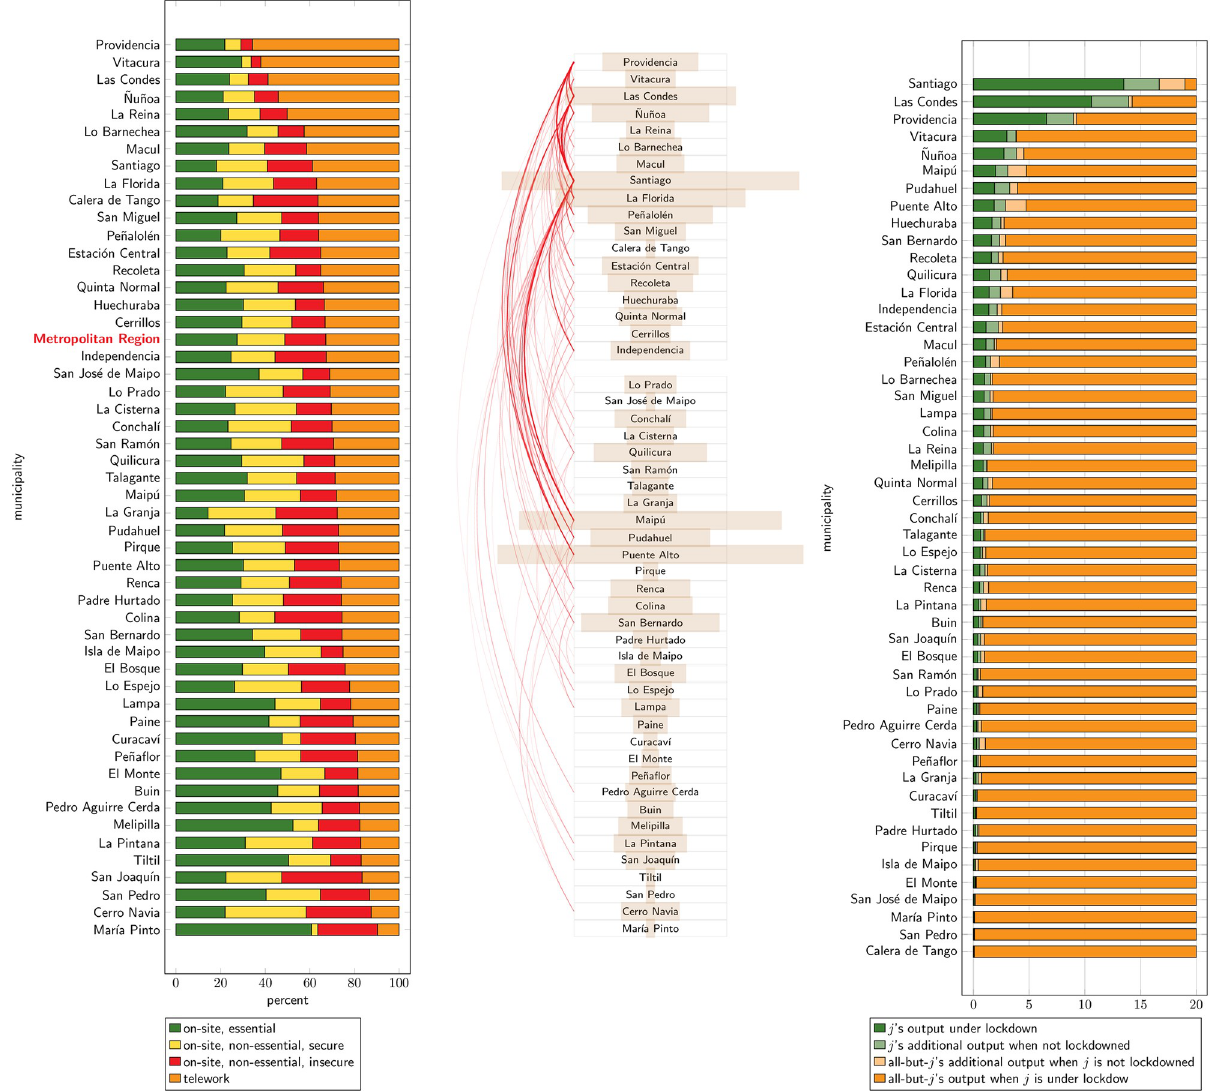
Fig 3. Baseline by municipality. (a) Percentage of employed workers by municipality of residence. Type I green; Type IIa yellow; Type IIb red; Type II orange. Sorted by the latter category. (b) In red, baseline commuting flows. The strongest connection is that of Providencia and Santiago; 1 percent of the SMR’s commuters travel between them. Only the strongest connections are depicted. Brown bars measure municipality size, by number of workers that live in each municipality. (c) Total output of each municipality (green) and of the rest of the SMR (orange), as a fraction of the latter. In light green, the decrease in the municipality’s output when it is put under lockdown. In light orange, the decrease in the rest of the SMR’s output when each municipality is put under